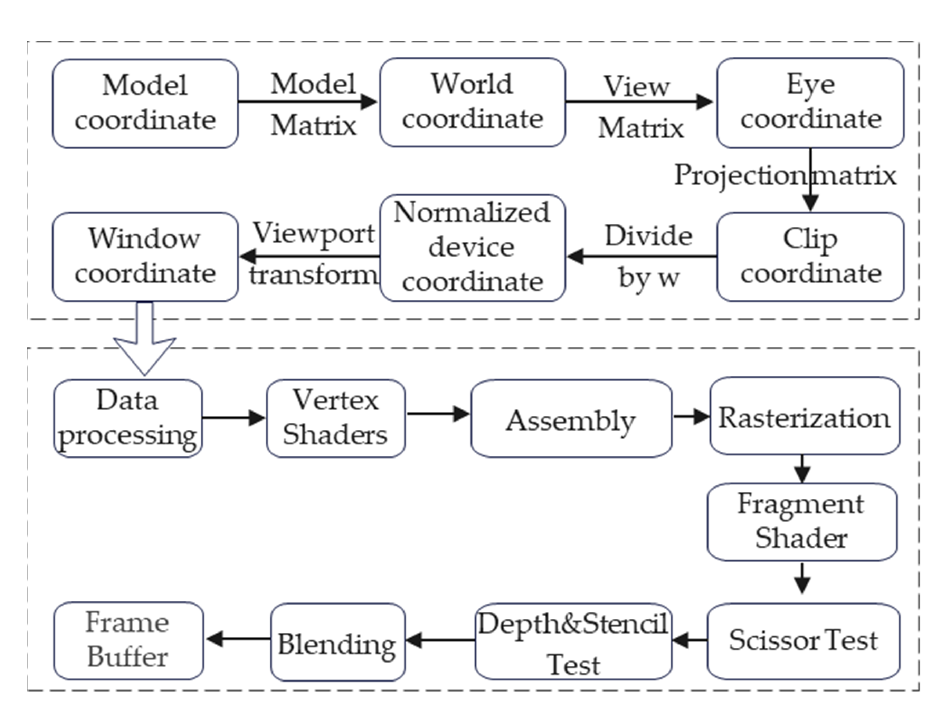
Figure 4. WebGL rendering pipeline.